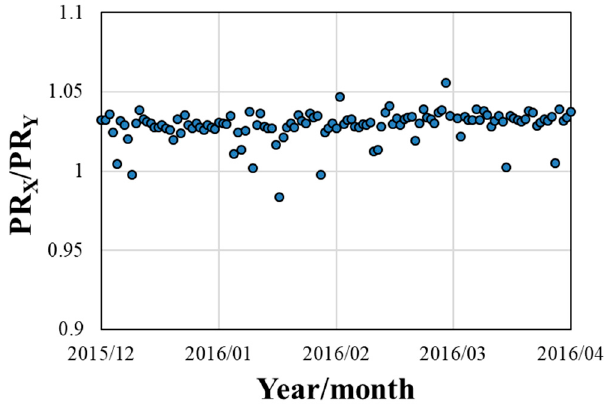
Figure 6. PR X / PR Y ratio versus time.